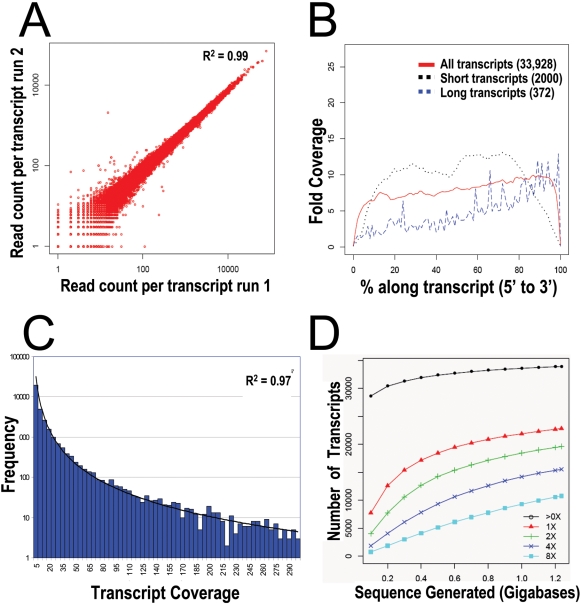
Characteristics of cDNA sequencing-by-synthesis with Illumina/Solexa instrument.(A) Run-to-run comparisons of the number of reads aligned per reference transcript for 2 SBS runs of cerebellar cortex #41 (21.6 and 17.0 million reads, respectively). Runs used the same library but were performed on different sequencing instruments on different days. Coefficient of variation was 3.4%. (B) Histogram showing coverage along an “averaged” reference transcript for 1.2 Gb of cerebellar cortex #41 cDNA sequences. Coverage was calculated at 1% intervals along each transcript to which reads aligned. At each interval coverage was averaged across all transcripts and plotted. “Short transcripts” are all transcripts of ≤500 bp to which reads were aligned. “Long transcripts” are all transcripts ≥10 kb to which reads were aligned. Numbers in parentheses are the number of transcripts represented by each category. (C) Histogram showing greater than exponential decline in frequency with increasing SBS coverage on reference transcripts for cerebellar cortex #41 (1.2 Gb). Of 33,938 transcripts, 111 had more than 300× coverage. Maximum coverage was 2323×. Best fit power trendline is shown. (D) Histogram showing the number of reference transcripts covered as a function of the amount of sequence generated. Different levels of minimum average coverage were examined: at least one read aligned (black circles), 1× average coverage (red triangles), 2× average coverage (green “+”), 4× average coverage (dark blue “×”), and 8× average coverage (light blue squares). Data are from SBS of cerebellar cortex #41 (1.2 Gb).